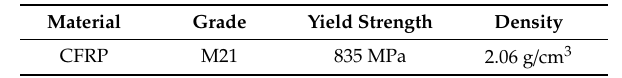
Table 1. Properties of carbon fibre-reinforced polymer composites